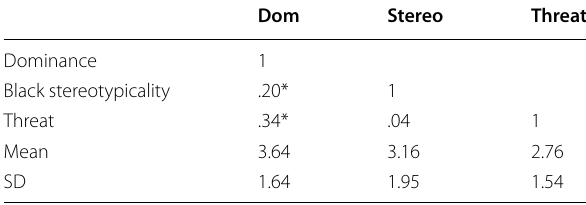
Table 4 Descriptive statistics (zero‑order